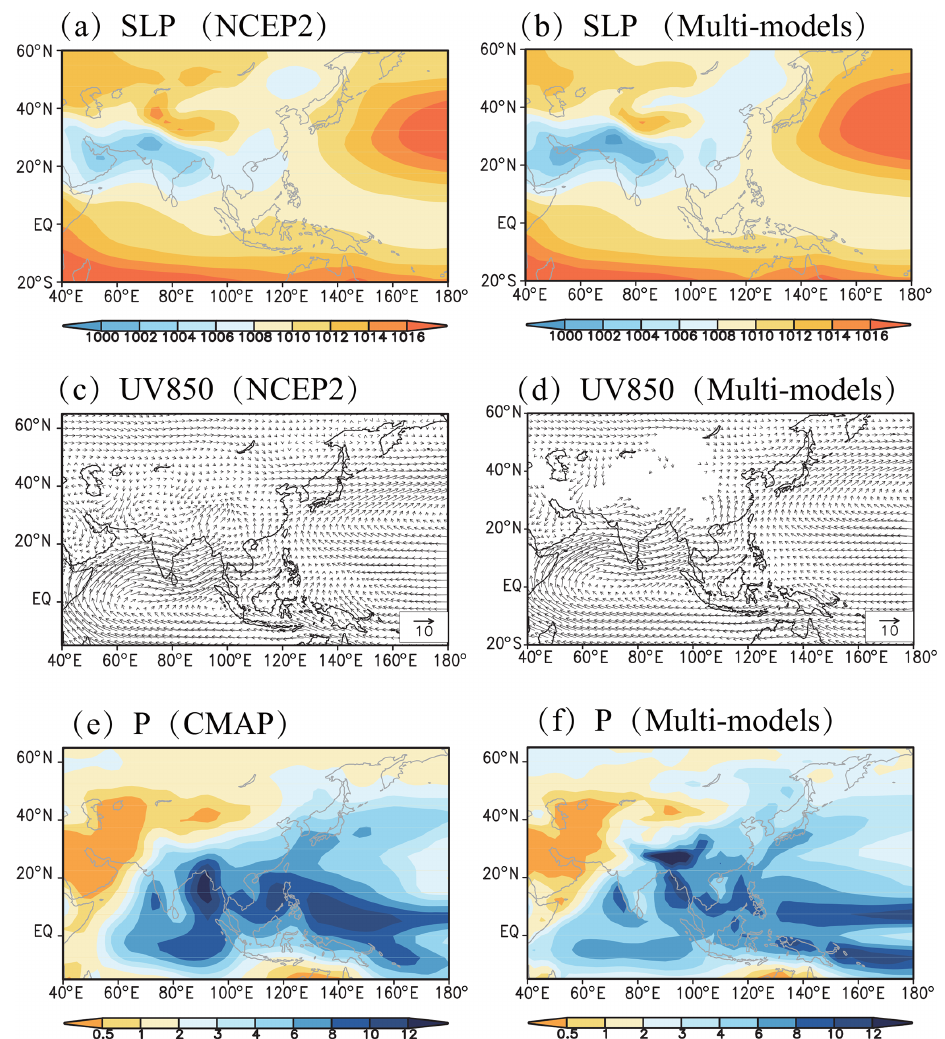
Figure 2. Comparison of the climatological MJJAS sea level pressure (SLP; unit: hPa), the wind field at 850hPa (UV850; unit: ms − 1 ) and precipitation ( P ; unit:mmd − 1 ) between (a, c, e) observations from 1979 to 2011 (NCEP2 wind field and CMAP precipitation) and (b, d, f) multimodel mean of the BASE experiments.